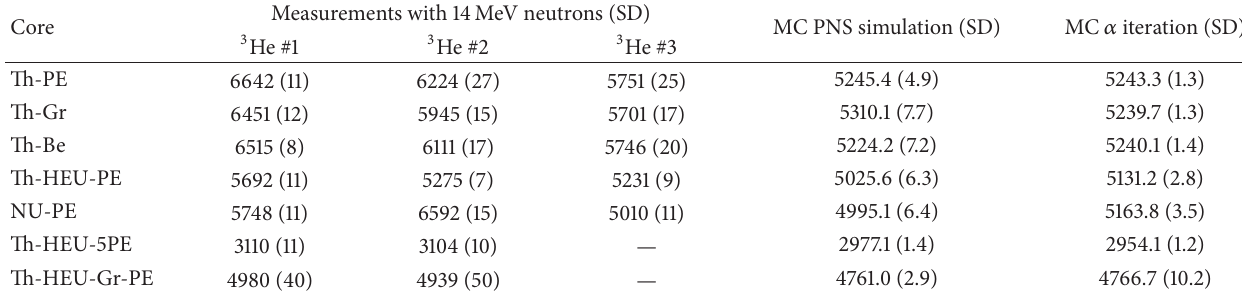
Table 3: Comparisons of 𝛼 estimates for the Th-ADS experimental benchmark.